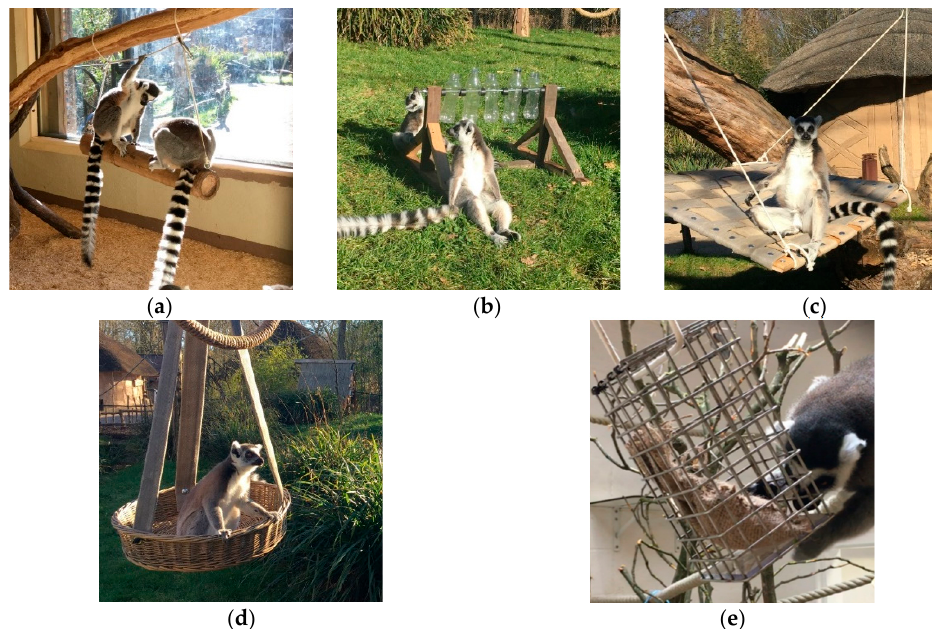
Figure 1. The enrichment items used in the study, including ( a ) tube swings, ( b ) bottle puzzles, ( c ) hammocks, ( d ) baskets and ( e ) scented bags. ( c ) hammocks, ( d ) baskets and ( e ) scented